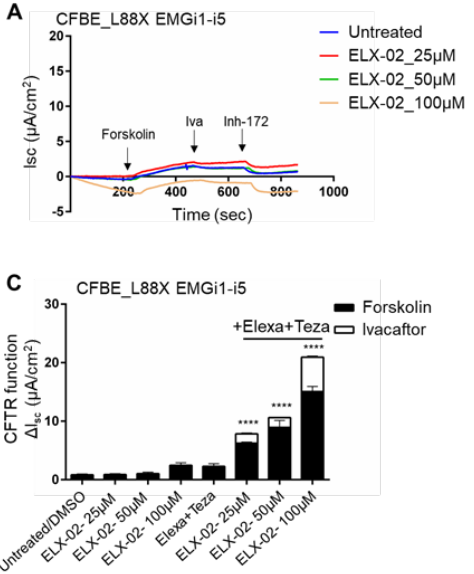
Figure 4. Combination treatment of readthrough ELX-02 with CFTR modulators restores L88X CFTR function in a dose dependent manner in CFBE stable cells. ( A ) Short circuit current (Isc) assay in CFBE cells stably expressing L88X- CFTR- EMGi1-5 grown on snapwells. CFBE cells were mounted on Ussing chambers to measure CFTR mediated chloride activity as a proxy to CFTR function. Cells were incubated for 24 h with varying concentrations of readthrough compound ELX- 02 (25 µM – 100 µM). Forskolin (10 µM) was added to the basolateral chamber, followed by potentiator ivacaftor (10 µM) and CFTR inhibitor Inh-172 (10 µM) added to the apical chamber. ( B ) Isc assay of CFTR channel function in CFBE cells stably expressing L88X- CFTR -EMGi1-i5. Cells were incubated for 24 h with varying concentrations of readthrough compound ELX-02 (25 µM – 100 µM) and CFTR correctors elexacaftor (3 µM) and tezacaftor (3 µM). Forskolin (10 µM) was added to the basolateral chamber, followed by potentiator ivacaftor (10 µM), and CFTR inhibitor Inh-172 (10 µM) added to the apical chamber. ( C ) Stacked bar plots indicate effect of ELX-02 readthrough concentration and modulator treatment on L88X- CFTR -EMGi1- i5 CFBE cells. Change in Isc (ΔIsc) was defined as the current inhibited by Inh-172 after sustained Isc responses achieved upon stimulation with forskolin alone or sequentially with ivacaftor. **** indicates p ≤ 0.0001. 3.5. RNA Analysis Confirms Presence of L88X Transcript in Nasal Epithelial Cells of Carrier Parent To further evaluate results in our EMG cell-based system, studies were performed on primary human nasal epithelial (NE) cells obtained from an individual carrying L88X/14adel, and their heterozygous parents. Reverse transcription polymerase chain